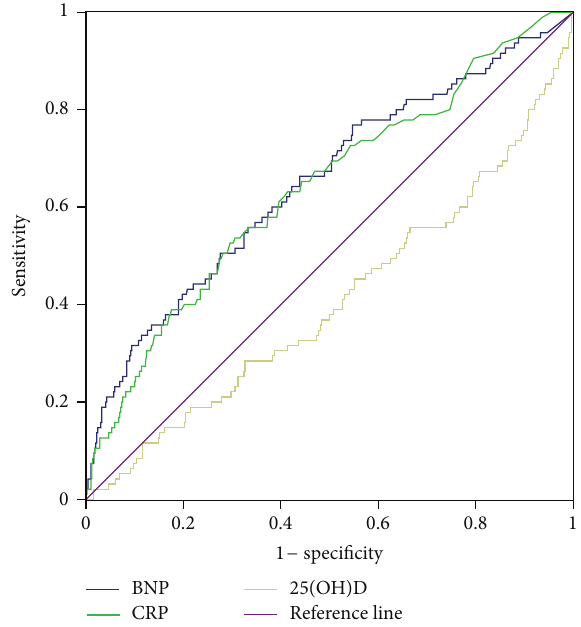
Figure 4: Receiver operating characteristic curves for 25(OH)D, BNP, and hsCRP for the evaluation of all-cause mortality in the male patient